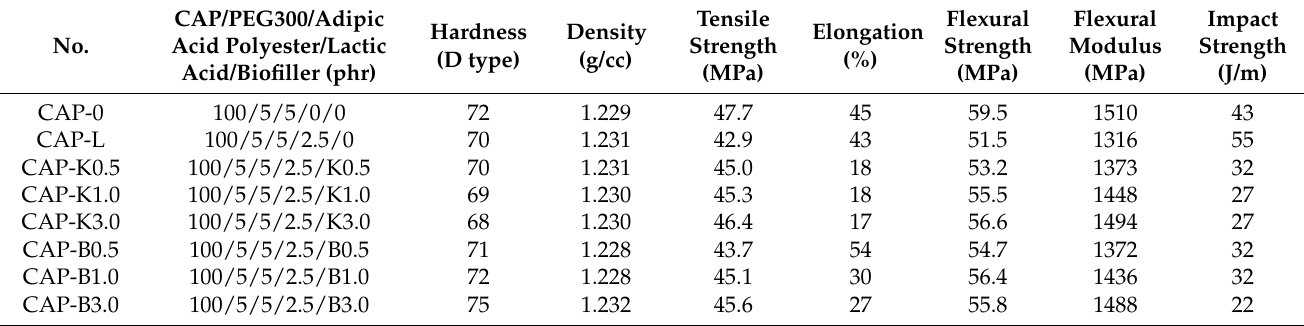
Table 3. Mechanical properties of CAP–biofiller composites with different